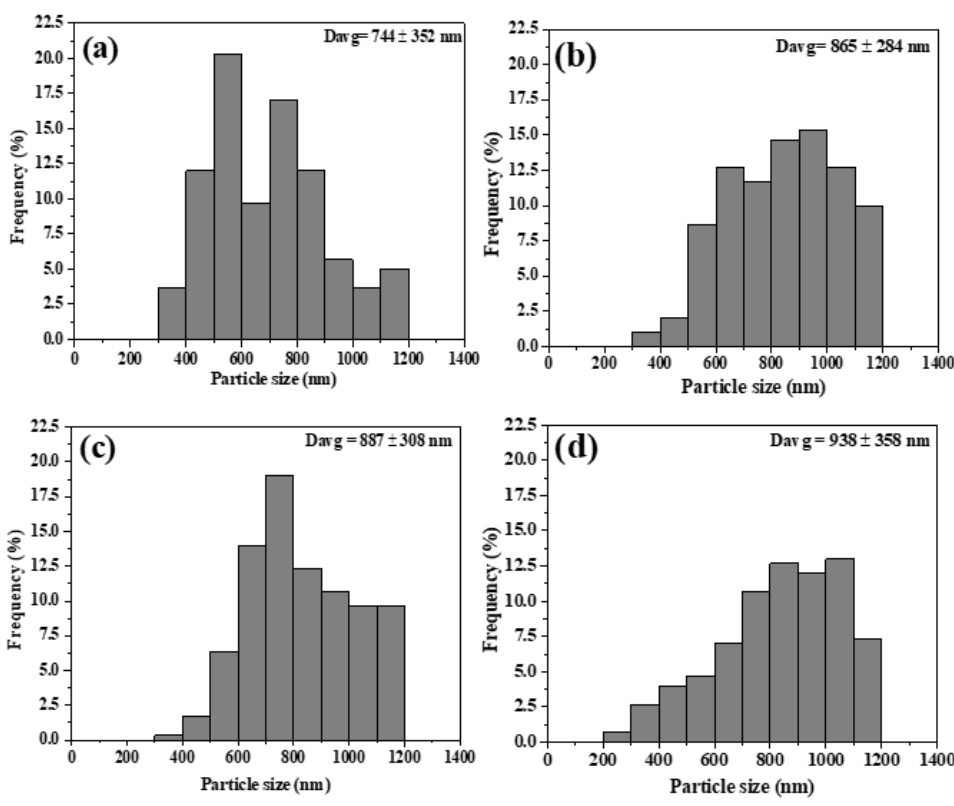
Figure 3. Particle size distributions of Mg 2 SiO 4 -calcined powders at temperatures of ( a ) 850, ( b ) 900, ( c ) 950, and ( d ) 1000 °C.